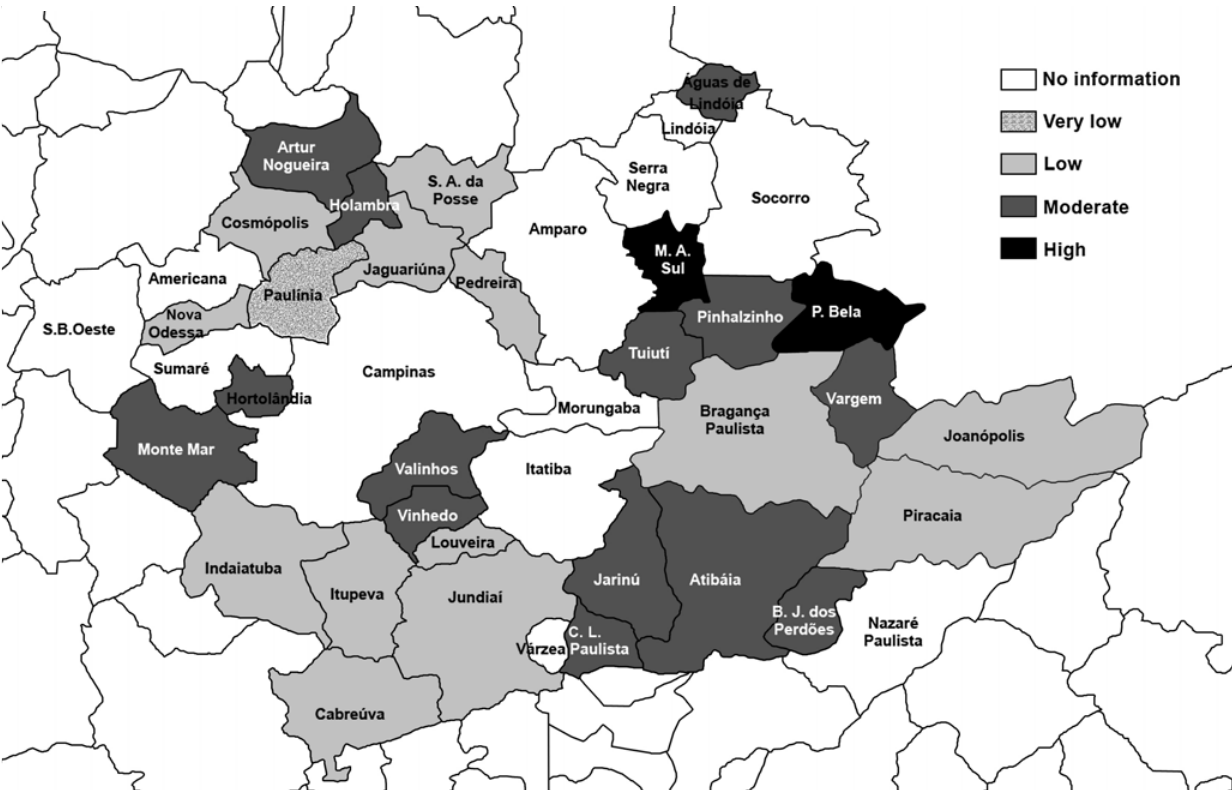
FIGURE 1- Dental caries prevalence according to the prevalence scale in cities from the region of Campinas, São Paulo State, Brazil (1998 to